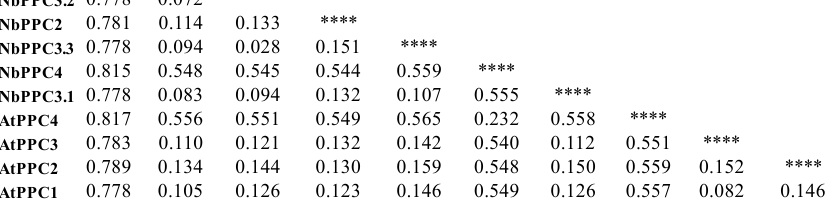
Figure 5. Phylogenetic analysis of N. benthamiana PEPCs. ( a ) Phylogeny of phospho enol pyruvate carboxylase (PPC) proteins and their isoforms in N. benthamiana and A. thaliana . For protein identifi- cation, “Nb” indicates N. benthamiana proteins and “At” indicates A. thaliana proteins. As outgroup was used a PEPC from Halobacterium salinarum (HsPPC). Bootstrap analysis was carried out with 100 replicates. Number at the branches correspond to the bootstrap frequencies for each branch. ( b ) Evolutionary divergence matrix estimated from PEPCs proteins sequences. The rate variation among sites was modeled with a gamma distribution (shape parameter = 1). **** means “not applicable”.